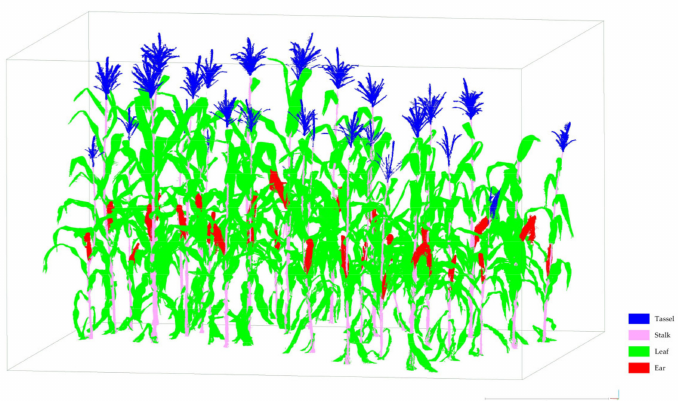
Figure 6. Schematic diagram of Maize-04 point cloud data label.